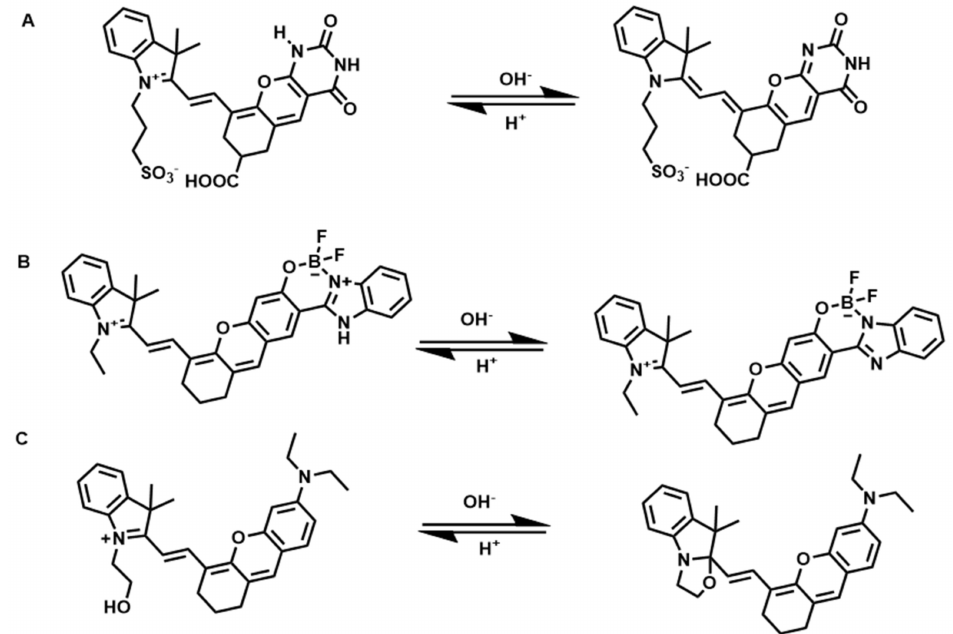
Figure 5. Responsive mechanisms for pH based on ( A ) uracil-containing hemicyanine dyes, ( B ) hemicyanine–boron fluoride conjugate and ( C ) oxazolidine switch in hemicyanine